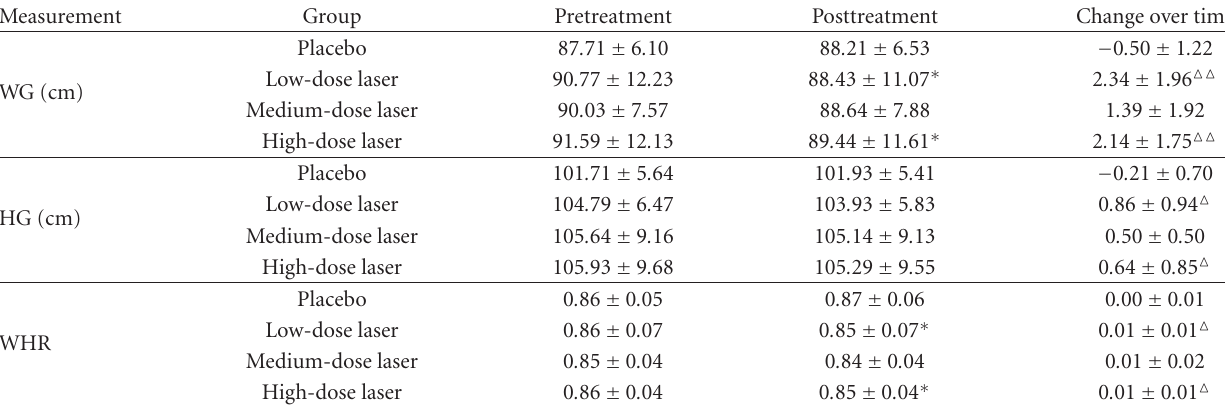
WG:waistgirth,HG:hipgirth,WHR:waist-to-hipratio.Asterisksindicatesignificantdi ff erencesfrompretreatment( ∗ P < 0 .